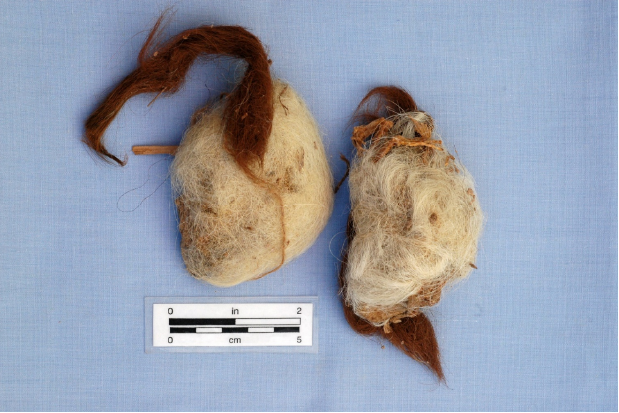
Figure 5. Mummified frogs wrapped in camelid fiber from Omo M10 Temple (photo by Susan D. deFrance).